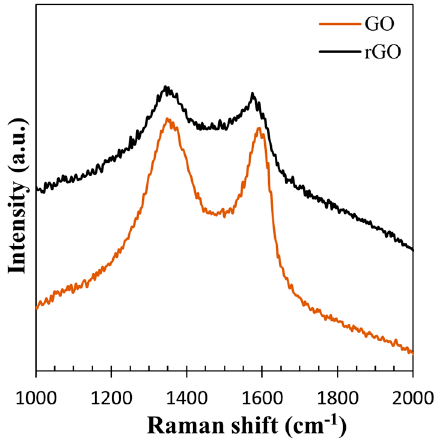
Figure 8. Raman spectra of GO and rGO synthesized using lemon juice.